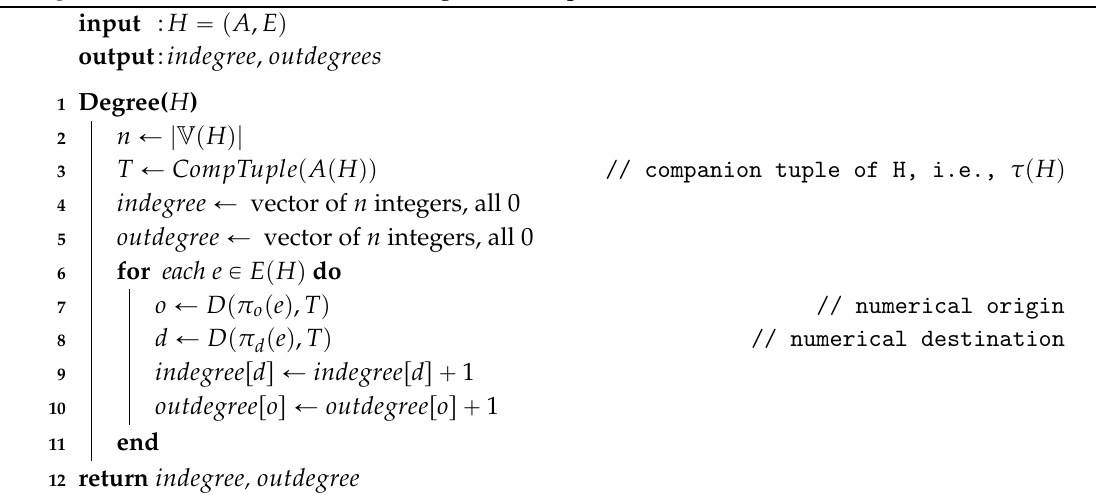
Algorithm 8: Determination of the degree of composite